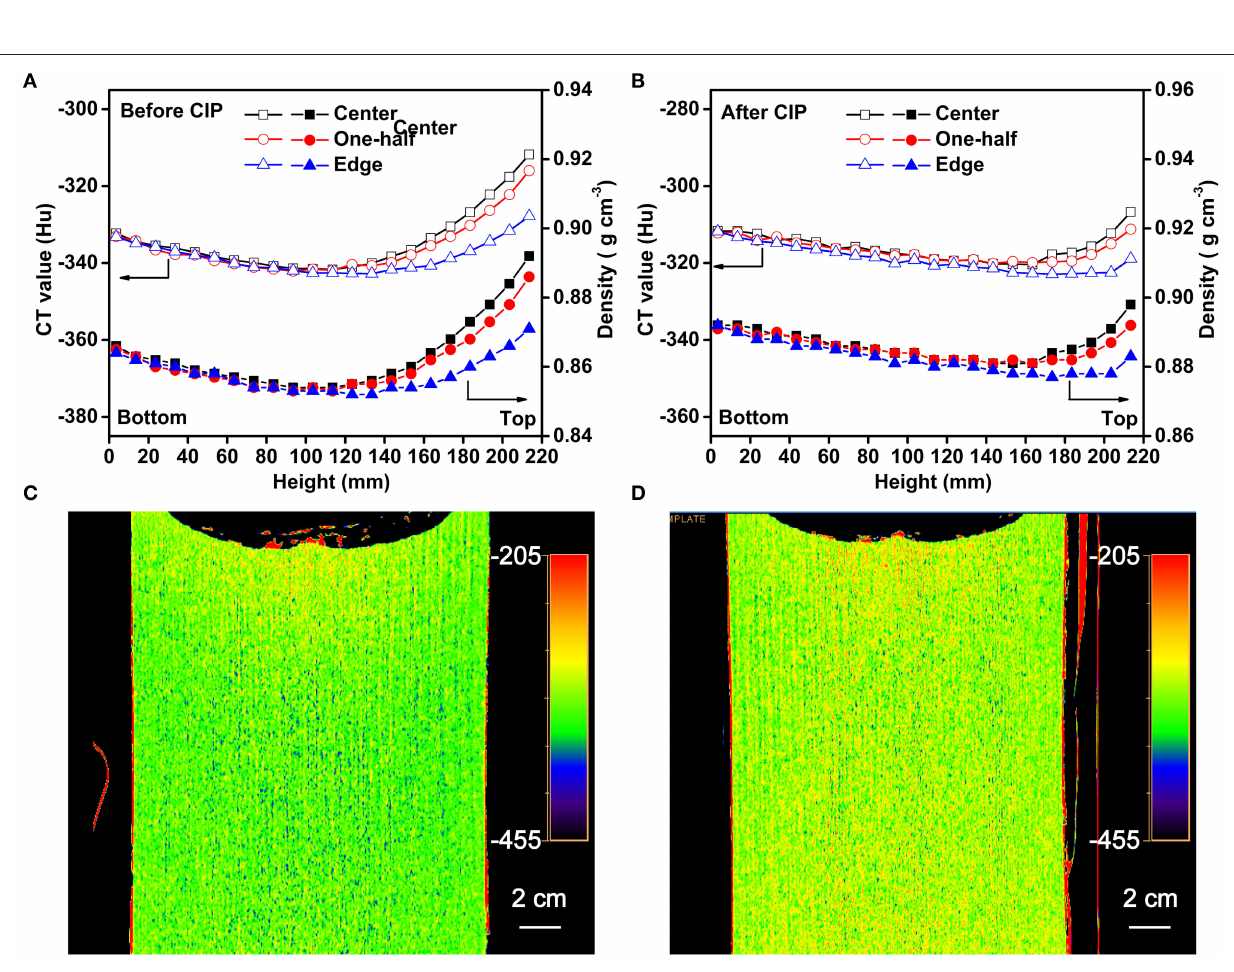
Frontiers in Chemistry |